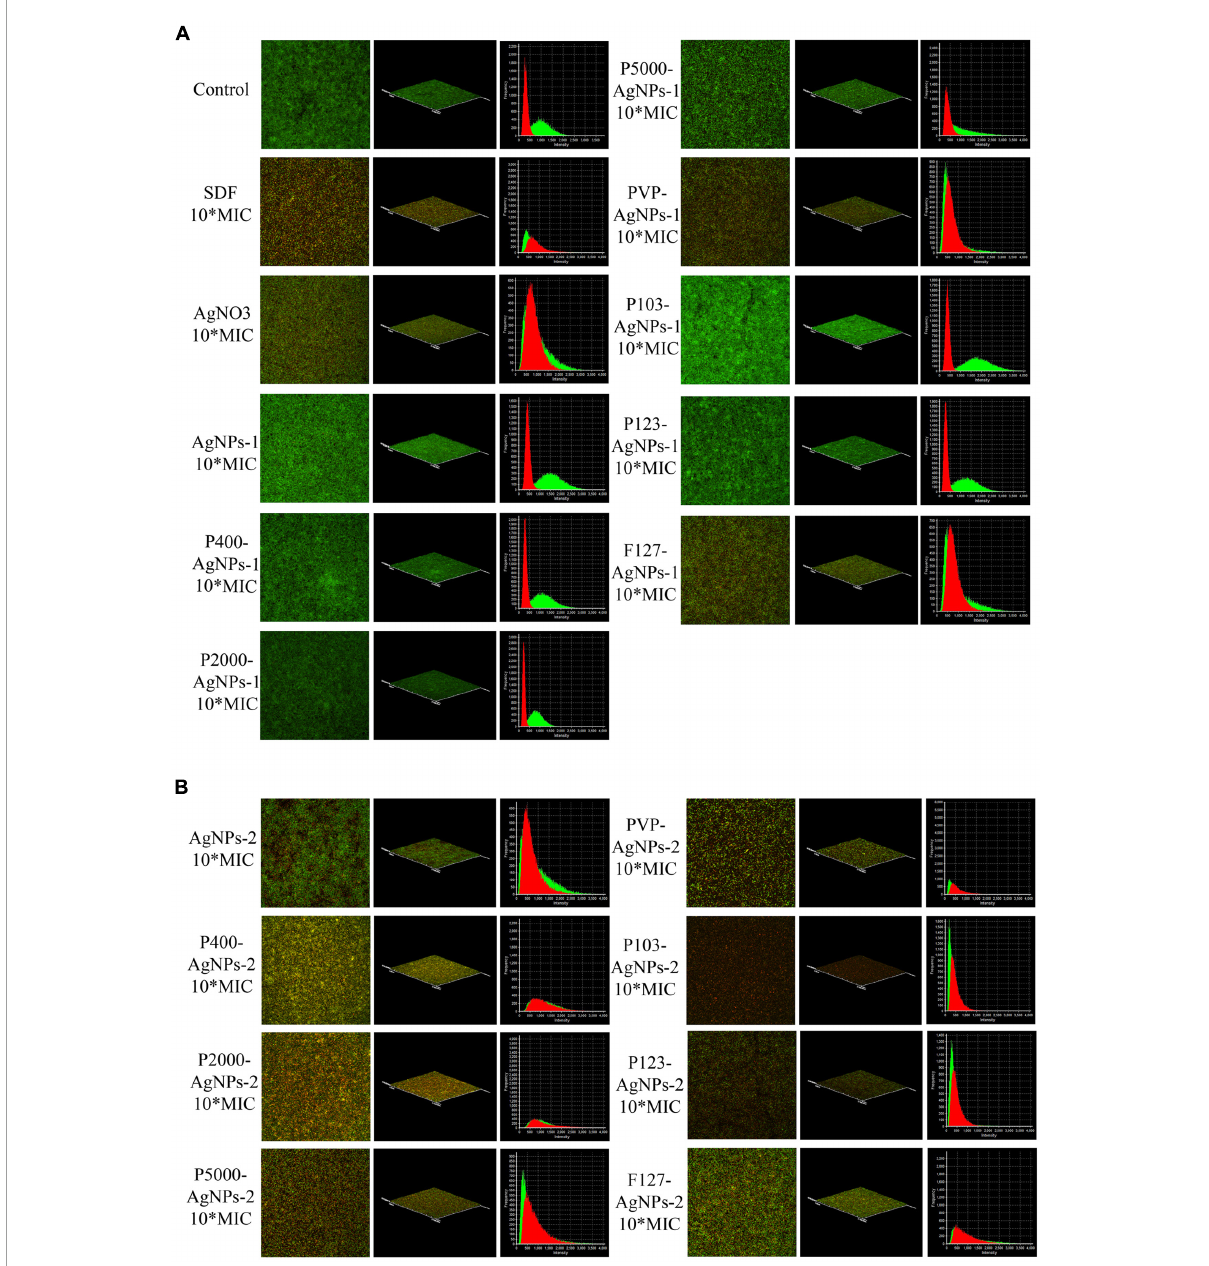
FIGURE5 CLSM images at 60 × magnification show the antibiofilm effect of (A) SDF, AgNO3, AgNPs-1, P-AgNPs-1 and (B) AgNPs-2 and P-AgNPs-2 on P. gingivalis biofilm (Live/Dead bacterial viability kit), including merged images, 3D models, and intensity-frequency area graphs. Red for dead bacteria and green for live